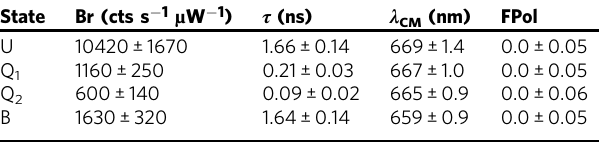
Table 1 Extracted photophysical parameters for each state